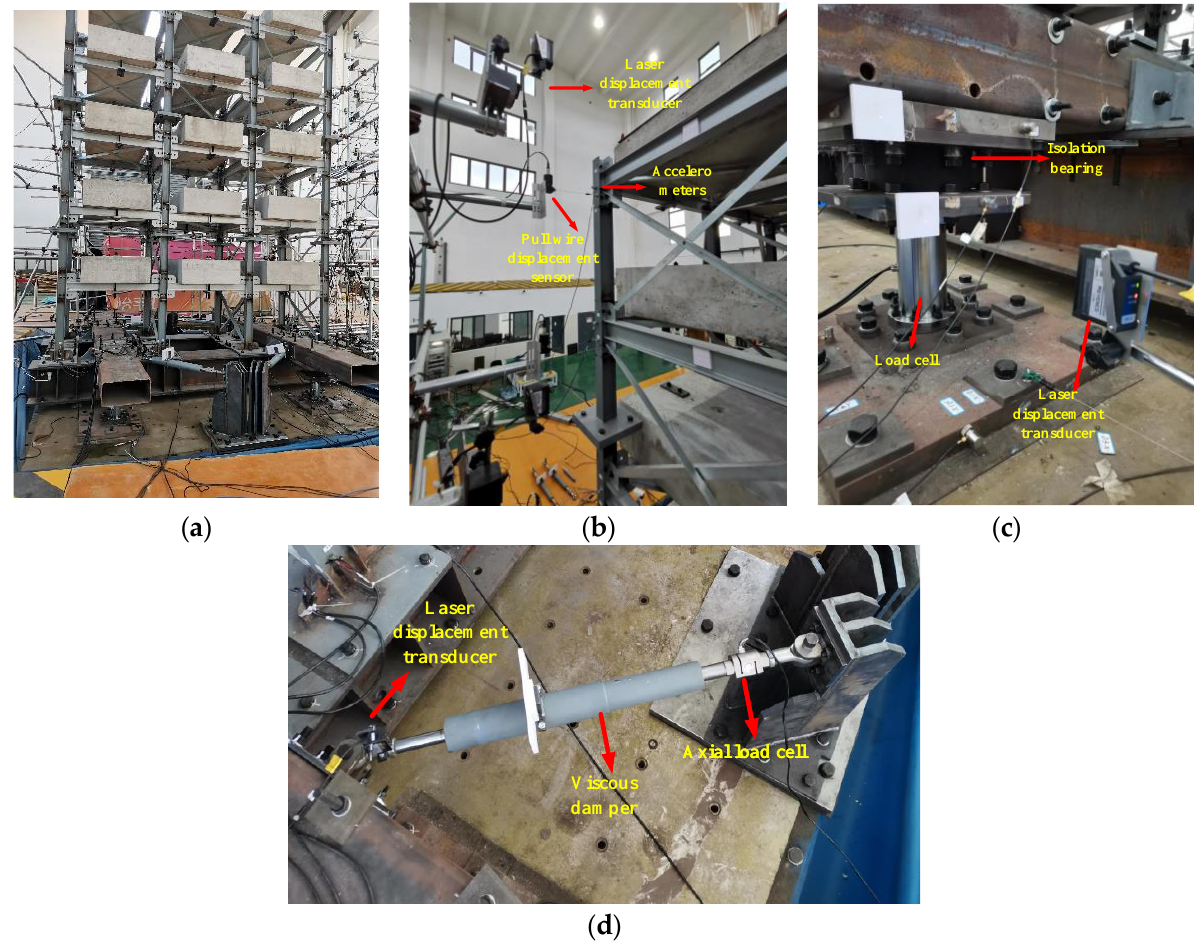
Figure 5. Sensors of viscous dampers: ( a ) Test model structure; ( b ) Sensors of the superstructure; ( c ) Load cell — six components; ( d ) Sensors of NLVDs.